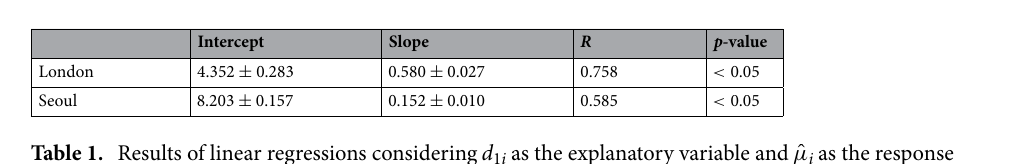
Figure 2. Relationship between the mean of the distribution of journeys terminating at each station, ˆ µ and the distance d 1 i between the nucleus S 1 and the destination station S i .